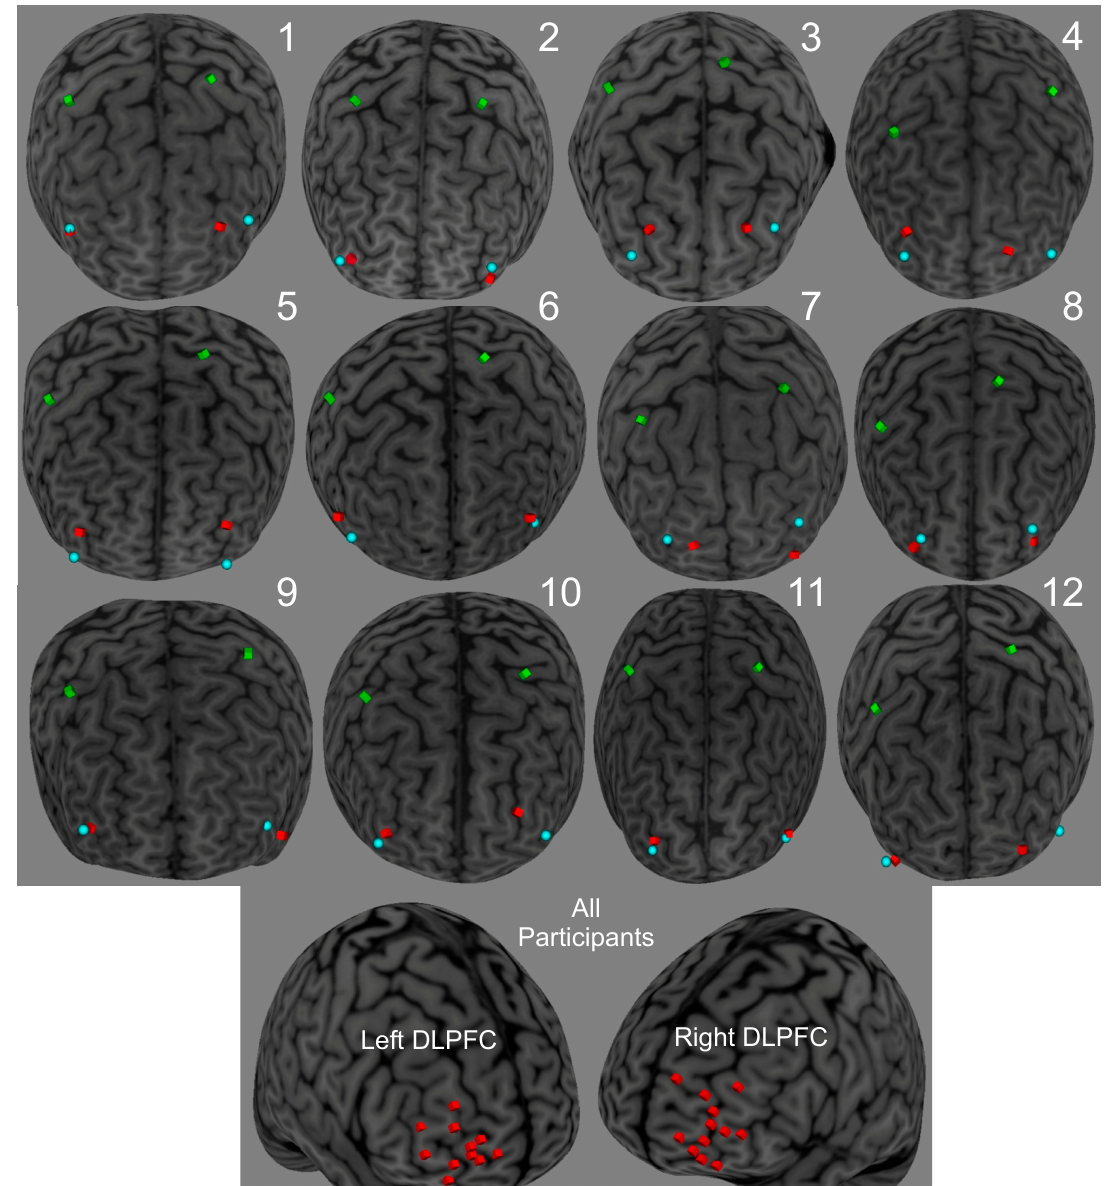
Figure 2. Dorsolateral prefrontal cortex (DLPFC) anatomical, DLPFC stimulation and M1 stimulation locations for Experiments 1–4 for the 12 participants based on individualized MRIs using neuronavigation software. We adjusted the targeted DLPFC stimulation sites to accommodate for both transcranial magnetic (TMS) coils on the scalp. Green cubes denote M1 stimulation locations, blue spheres denote DLPFC anatomical locations, and red cubes denote DLPFC stimulation locations.